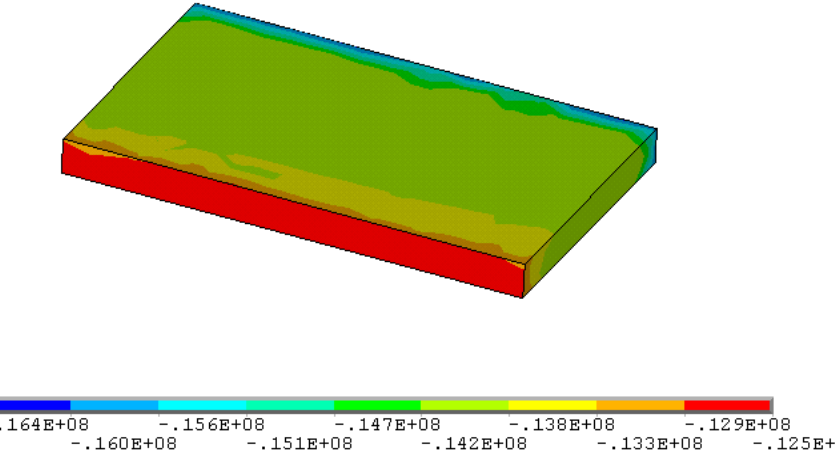
Figure 8. Maximum principal stress distribution in the ore block at 1480 mL before mining (parameters before optimization: stope height 3 m, pillar diameter 3 m, pillar spacing 7 m, pillar row spacing 9 m).